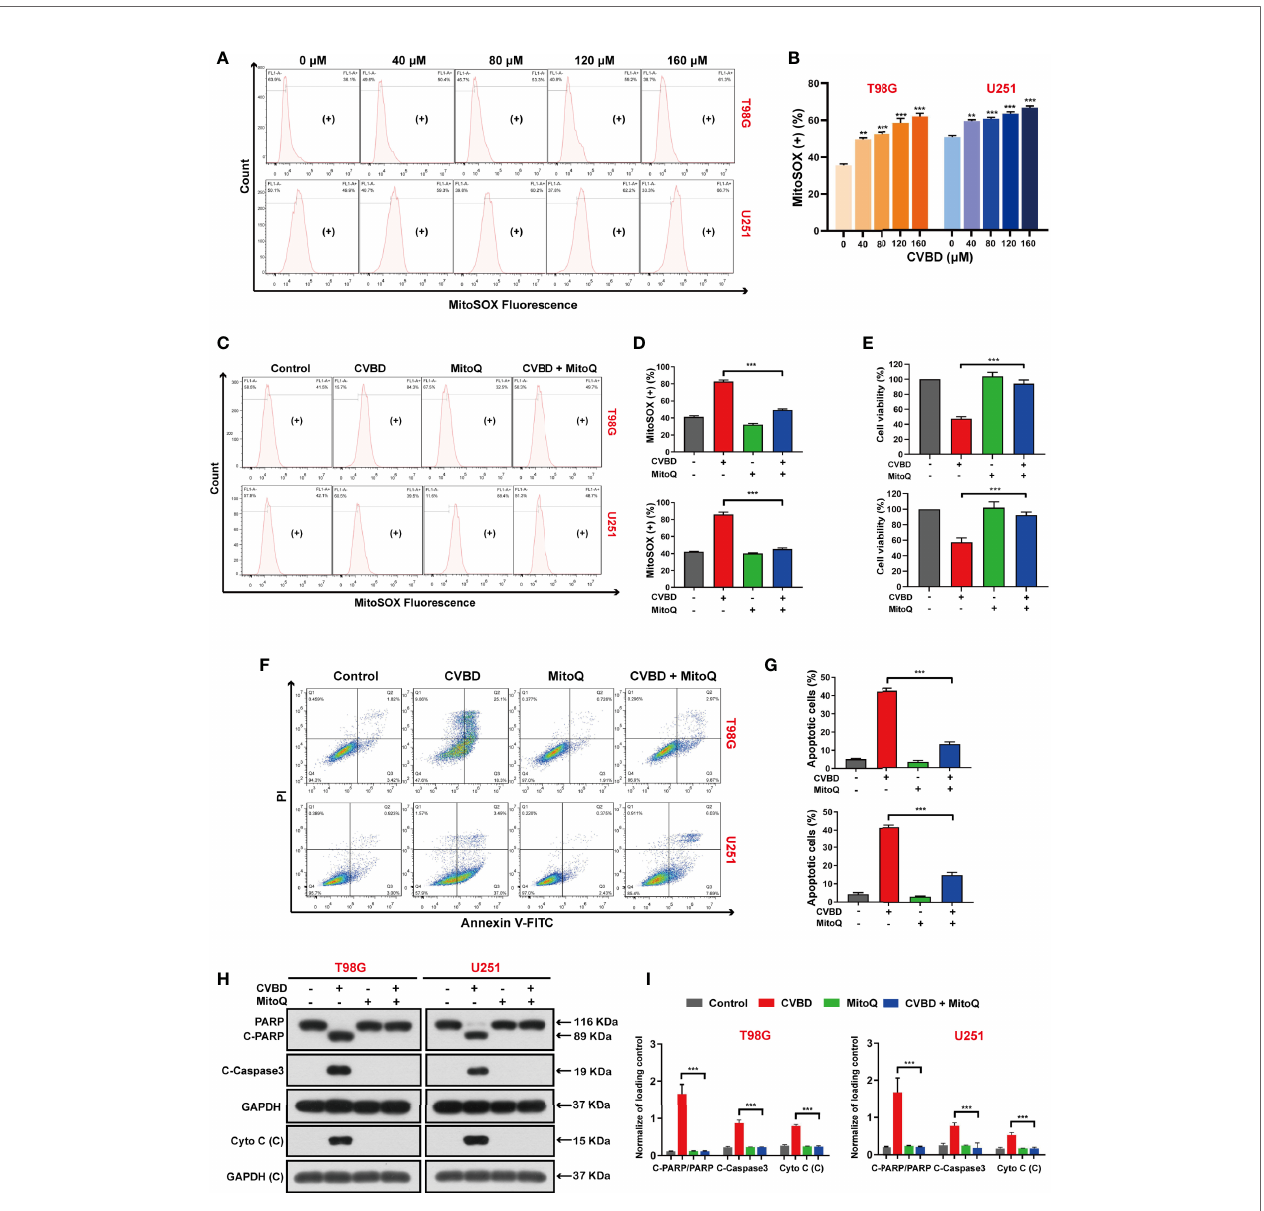
FIGURE 6 | CVBD induces mitochondrial superoxide generation and MitoQ inhibits mitochondrial superoxide production, which attenuates CVBD-mediated apoptosis. (A, B) T98G and U251 cells were exposed to various concentrations of CVBD for 24 h, and 0 m M CVBD was used as the control group. The mitochondrial superoxide generation was detected by fl ow cytometry using MitoSOX ™ Red staining (mean ± SD of three independent experiments, **P < 0.01, ***P < 0.001 compared with the control group). (C, D) T98G and U251 cells were pre-treated with MitoQ (0.5 m M, 30 min) and post-treated with CVBD (120 m M) for 24 h. The mitochondrial superoxide generation was detected by fl ow cytometry using MitoSOX ™ red staining. (E) T98G and U251 cells were treated as indicated in (C) , and the cell viability was examined by CCK-8 assay. (F, G) T98G and U251 cells were treated as indicated in (C) , and the apoptosis was detected by AnnexinV- FITC/PI staining and fl ow cytometry. (H, I) T98G and U251 cells were treated as indicated in (C) , and the expression of PARP, C-PARP, C-Caspase3, and Cyto C (C) was determined by Western blotting analysis. GAPDH was used as a loading control (mean ± SD of three independent experiments, **P < 0.01, ***P < 0.001 compared with CVBD treatment